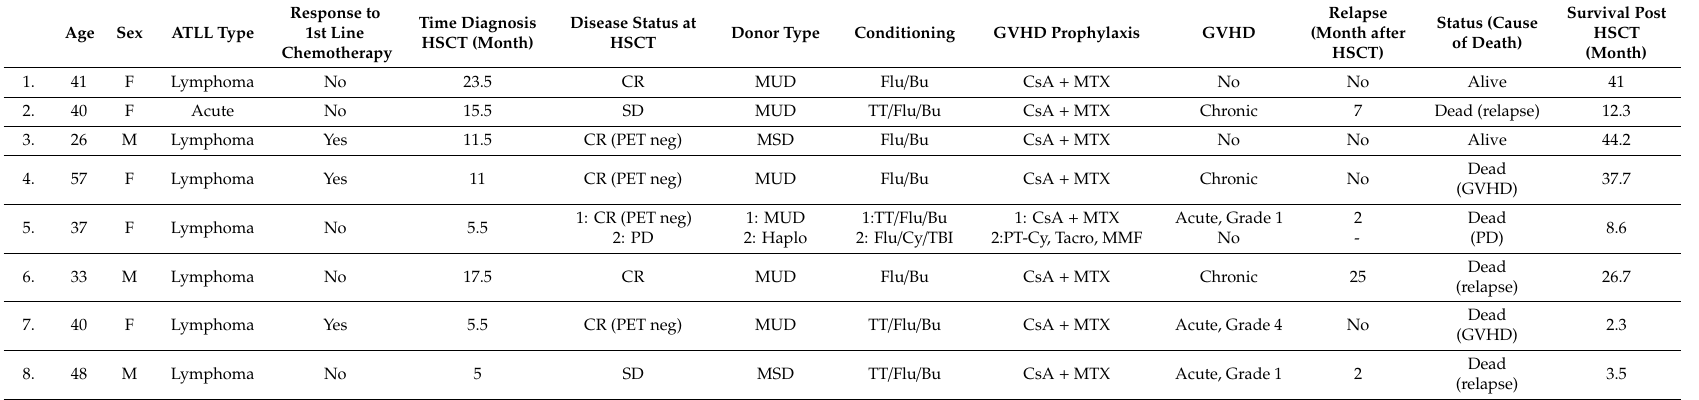
Table 2. Patient treatment and